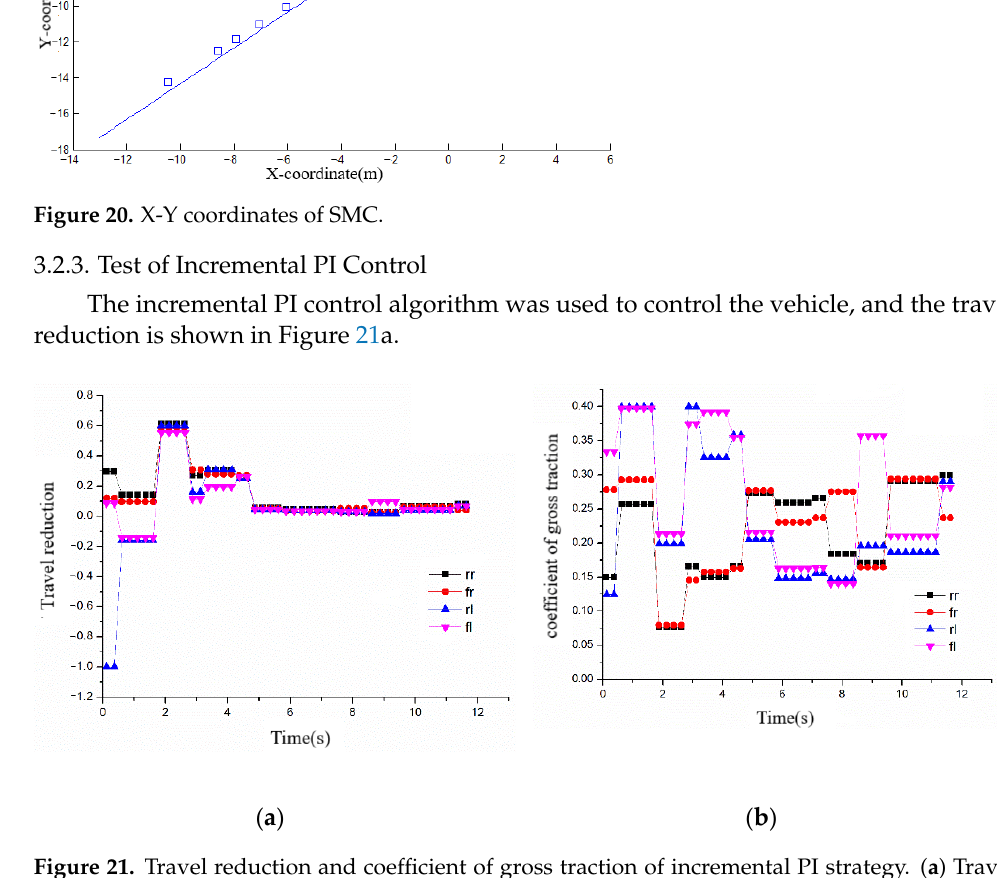
Figure 21. Travel reduction and coefficient of gross traction of incremental PI strategy. ( a ) Travel reduction; ( b ) Coefficient of gross traction.